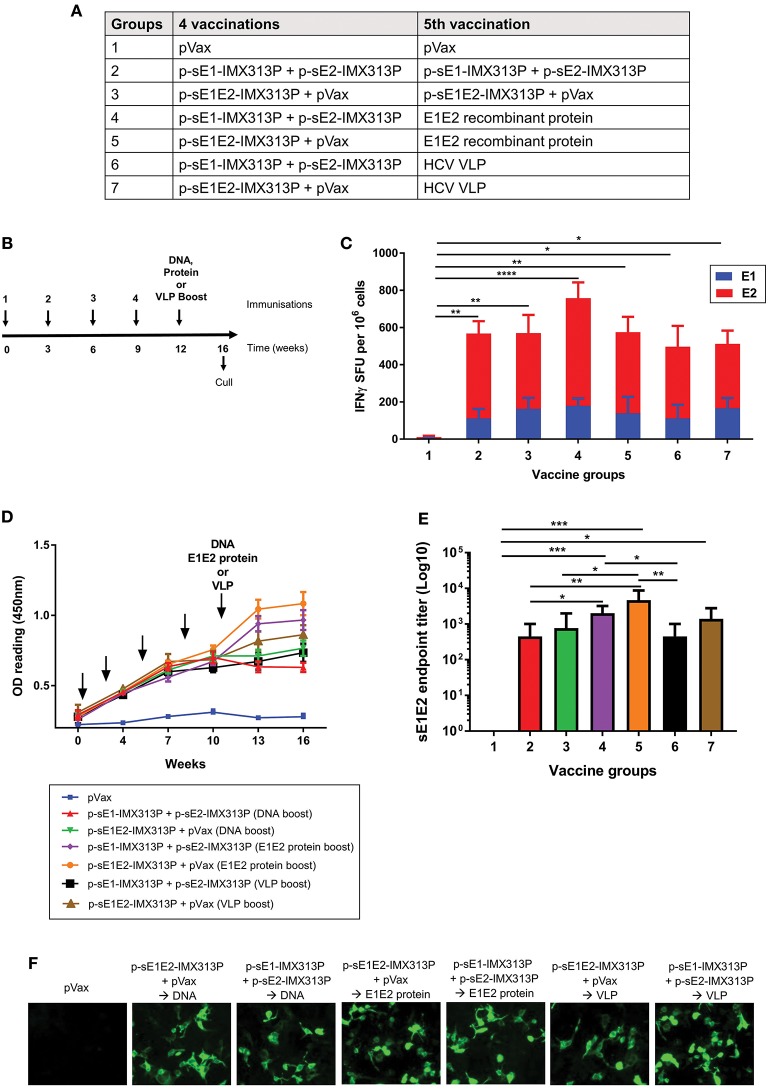
Boosting with recombinant sE1E2 protein augments the cellular and humoral immunity elicited in mice previously vaccinated with IMX313P adjuvanted DNA vaccines encoding secreted envelope proteins. (A) Vaccination groups and (B) immunization schedule of animals. The arrows indicate when the vaccines were administered. Female BALB/C mice (n = 7/group) were vaccinated at 3 weeks intervals via the ID route with 50 μg of p-sE1E2-IMX313P or p-sE1-IMX313P + p-sE2-IMX313P and boosted with DNA or E1E2 recombinant protein or HCV VLPs 3 weeks later. pVax was included in the vaccine cocktail to ensure that all animals were vaccinated with an equimolar amount of DNA. (C) IFN-γ ELISpot assay to examine E1- or E2-specific CMI in splenocytes stimulated with E1- or E2-peptides for 36 h. (D) Anti-E1E2-specific antibodies levels measured by ELISA (at 1:50 dilution) at the indicated time points. (E) sE1E2-specific serum IgG 4 weeks after the final immunization. Titers are expressed as the reciprocal of the dilution factor of the serum and plotted as Log10. The data represent mean responses in each group (n = 7) ± SEM. *p < 0.05, **p ≤ 0.01, ***p ≤ 0.001; and ****p ≤ 0.0001 (Mann-Whitney non-parametric t-test). (F) Immunofluorescence analysis of antibodies specific for full-length E1 and E2 proteins in immune sera. HEK293T were transfected with pVax-coreE1E2 encoding full length E1E2 proteins and pooled sera from mice immunized were used as the primary antibody at a 1:50 dilution.